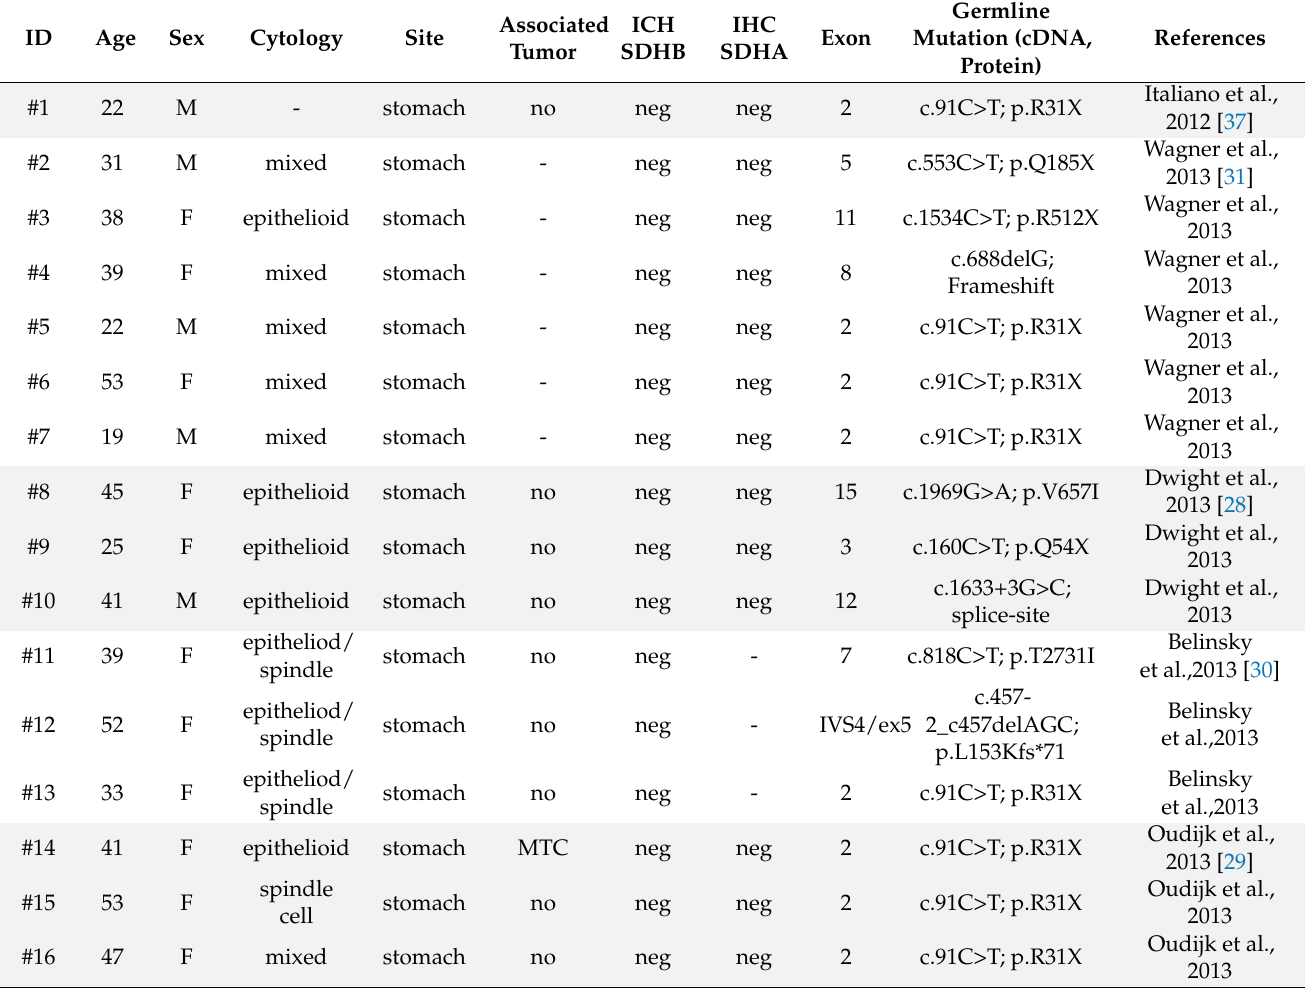
Table 1. List of SDHA germline mutations reported in SDH-deficient